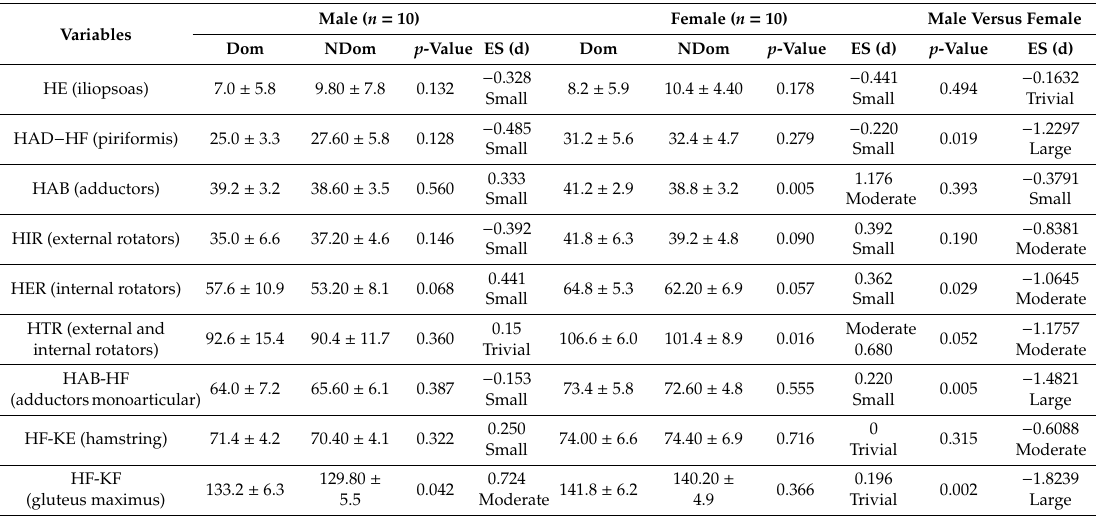
Table 2. Di ff erences in range of movement according to the sex and asymmetry in Spanish elite inline hockey players ( n =